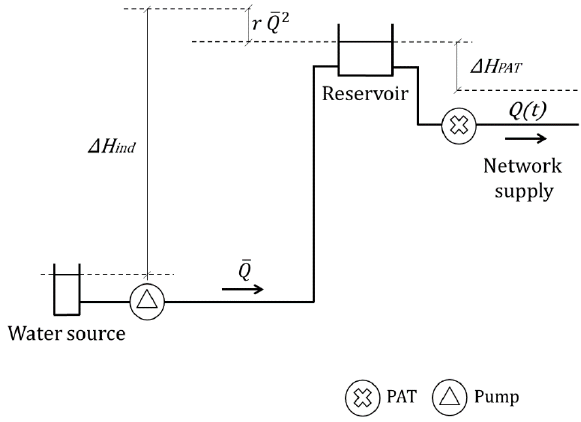
Figure 3. Scheme of indirect pumping with energy recovery. PAT: pump as turbine.